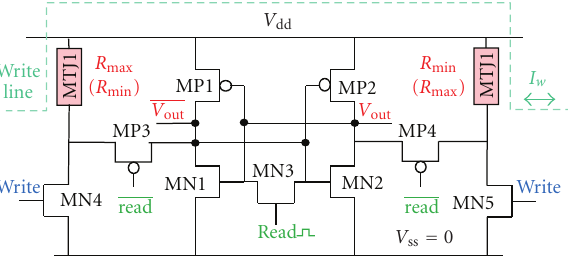
Figure 6: Second read/write structure for a TAS-MRAM memory.